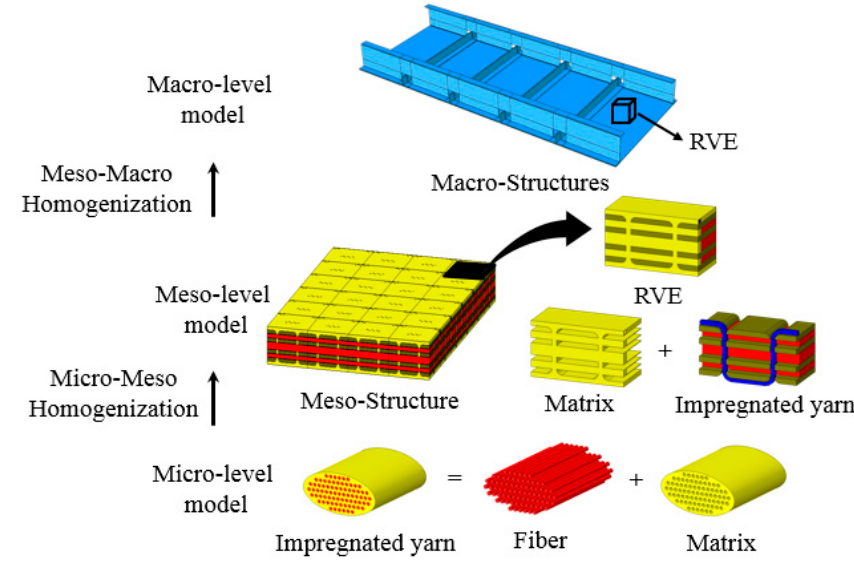
Figure 1. Multiscale modeling and homogenization in 3D fiber-reinforced composites (3D-FRC).